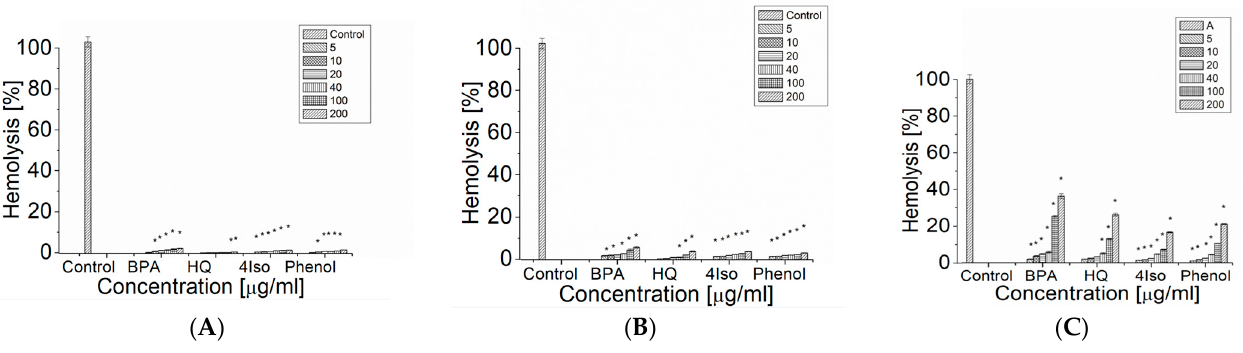
Figure 3. The hemolytic changes in the control erythrocytes and in those incubated with BPA, hydroquinone, phenol and 4-isopropylphenol in the concentration range 5–200 μ g/mL after 1 h ( A ), 4 h ( B ) and 24 h ( C ) of incubation. The data are presented as the means ± SE. * the effects of compounds were statistically significant.